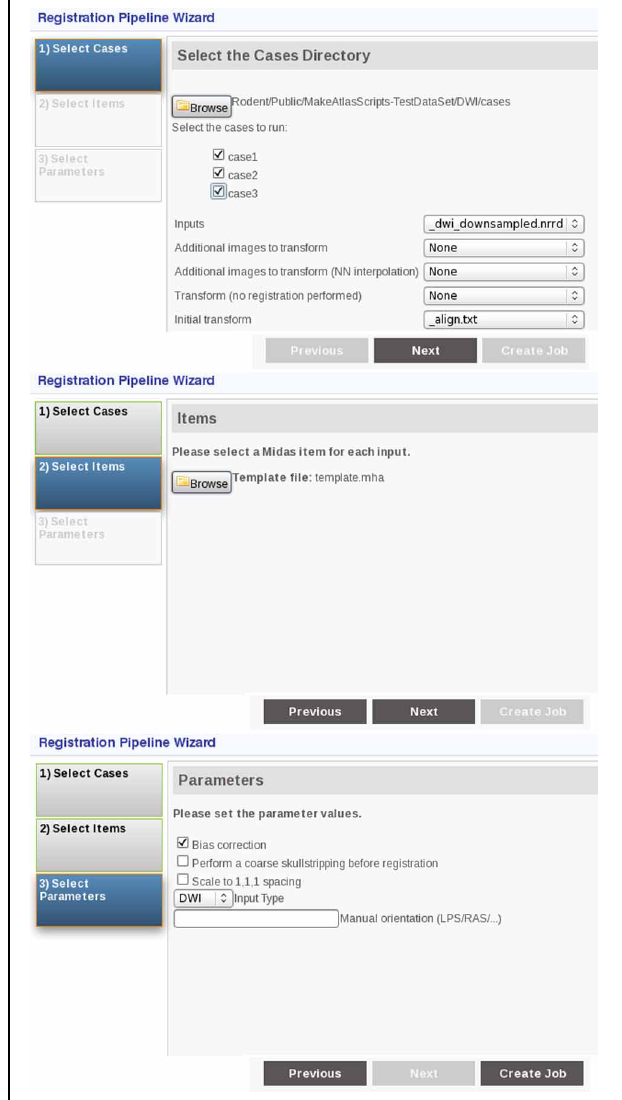
FIGURE 1 | Screenshots presenting the user interface of the pipeline when running the registration step. From top to bottom: selection of the images to register, selection of the fixed image for the registration, selection of the options including the type of the input